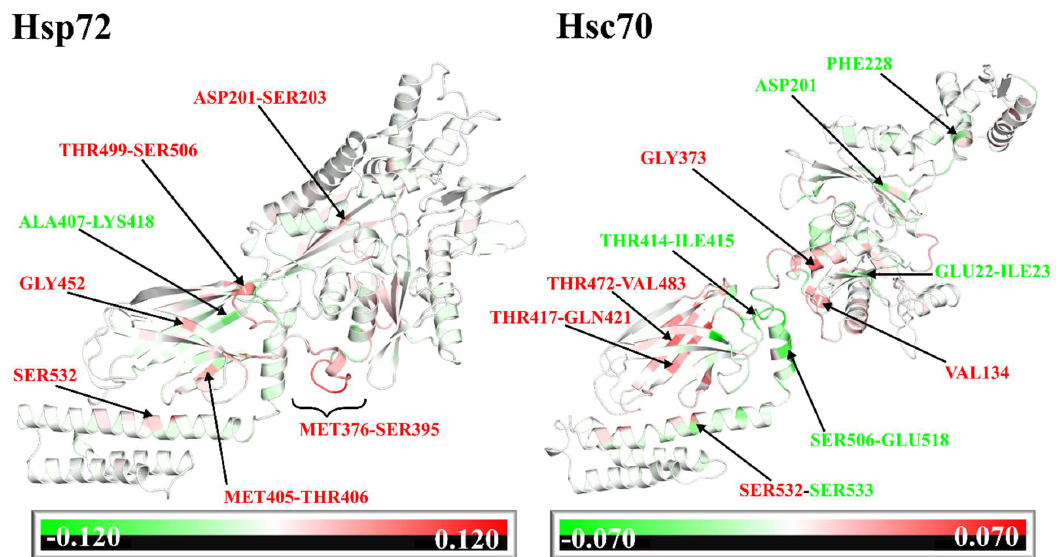
Figure 9. Structural mapping of residues showing significant changes in centrality index on snapshots of Hsp72-SANC00132 run1 and Hsc70-SANC00132 run1. Regions were coloured from green (negative changes or increased residue centrality) to red (positive changes or decreased residue centrality).